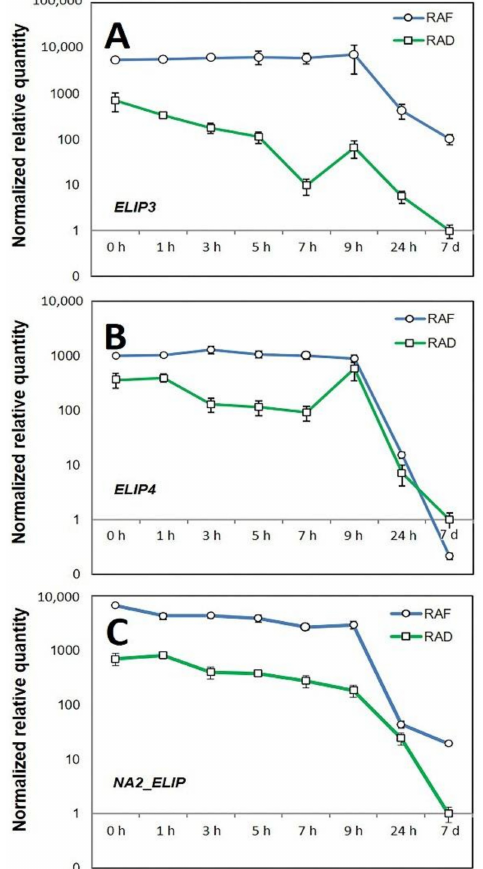
Figure 11. Relative transcript abundance of the ELIP genes: ELIP3 : Contig_024549 ( A ); ELIP4 : Contig_093552 ( B ); and NA2-ELIP : Contig_093441 ( C ) during recovery of H. rhodopensis after drought- (RAD) and freezing-induced desiccation (RAF). Normalized relative transcript abundances were scaled to the expression measured at 7 d of RAD, and the corresponding standard deviations are given ( n =